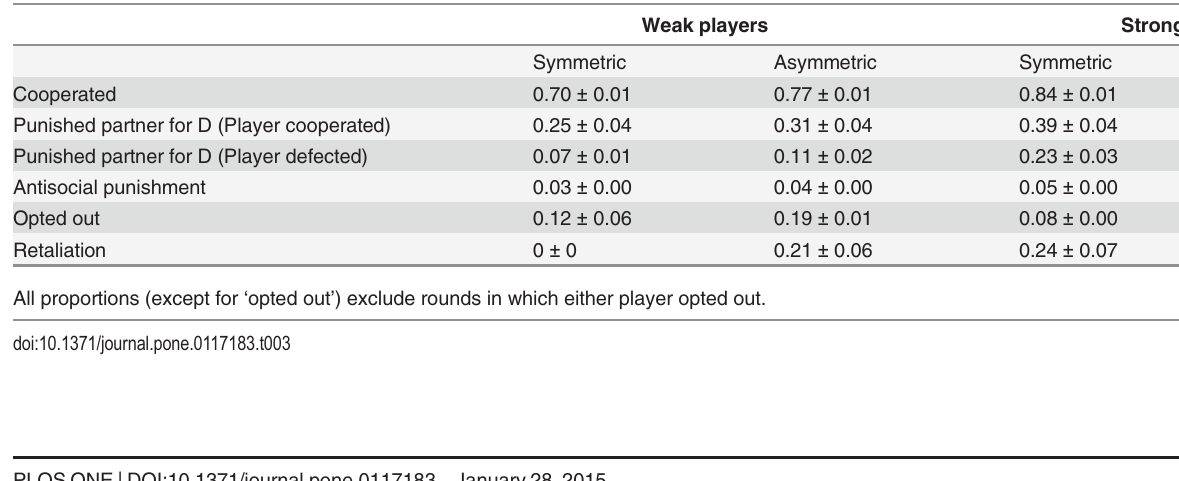
Table 3. The proportion of players who cooperated ( ± SE), the proportion of rounds in which players cooperated / defected / opted out, the proportion of instances in which the partner defected (D) / cooperated ( ‘ antisocial punishment ’ ) that cooperating players & defecting players responded with punishment and the proportion of instances in which players punished their partner in round n + 1 (when the partner cooperated) following being punished for defecting in round n ( ‘ retaliation ’